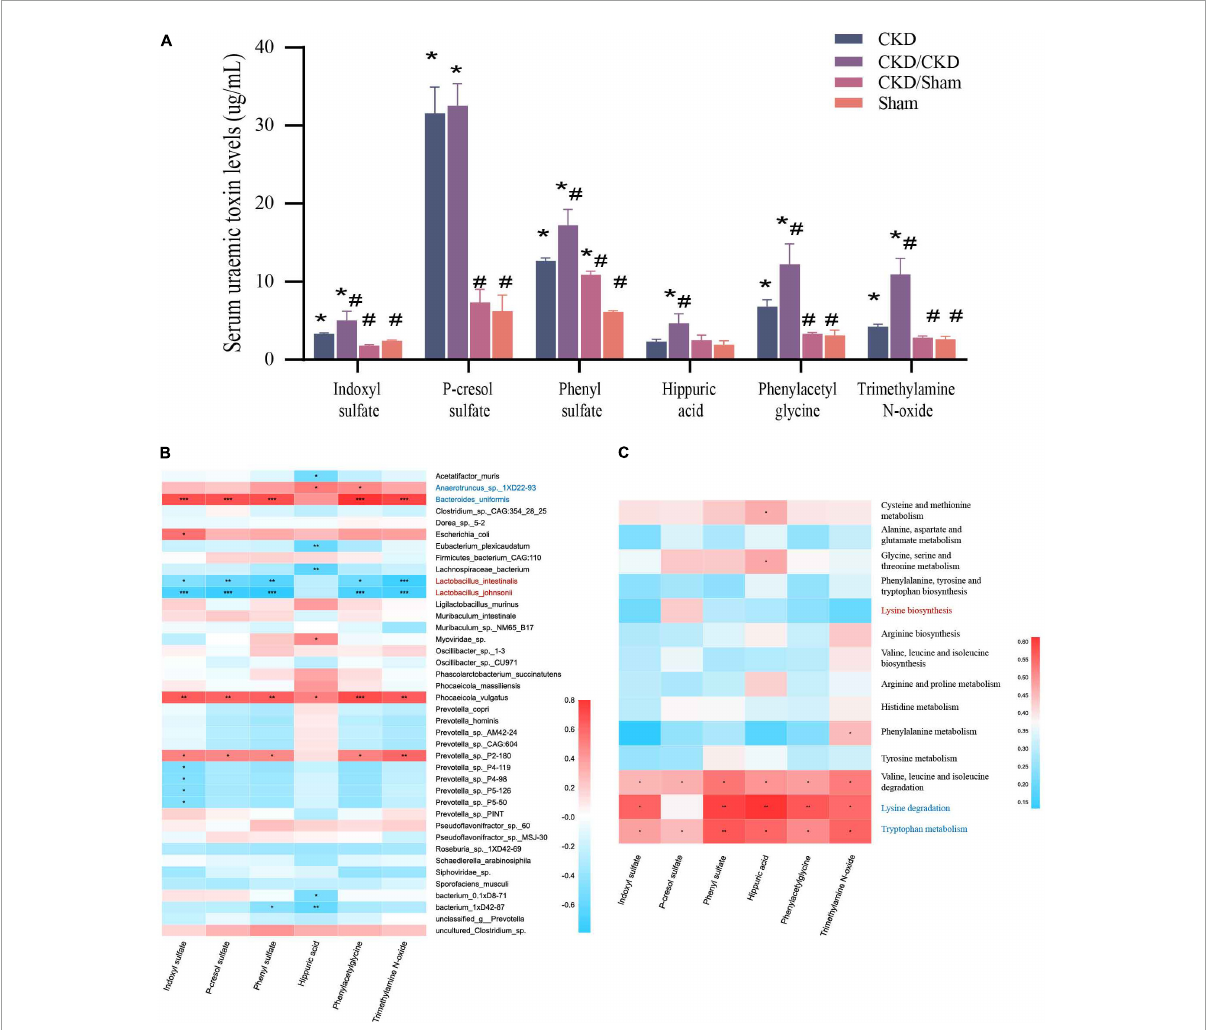
FIGURE8 (A) PBUTs levels after FMT. The data is presented as means ± SEM. n = 5. *VS Sham group P < 0.05, # VS group CKD P < 0.05. (B) Correlation heatmap between environmental factors and species with 1/2 nephrectomized after successful FMT. The X and Y axes are environmental factors and species, respectively, and the correlation coefficient R -values and the corresponding P -values were obtained by calculation. The R -values are shown in different colors in the figure, P < 0.05 is marked with *, and the right-hand legend shows the color intervals of different R -values. The clustering of species and environmental factors, respectively, is shown on the left and upper side of the figure. (C) Correlation heatmap between amino acid metabolism function and PBUTs with rats after successful FMT. The X and Y axes are environmental factors and amino acid metabolism function, respectively, and the correlation coefficient R -values and the corresponding P -values were obtained by calculation. The R -values are shown in different colors in the figure, P < 0.05 is marked with *, and the right-hand legend shows the color intervals of different R -values. The clustering of amino acid metabolism function and environmental factors, respectively, is shown on the left and upper side of the figure.